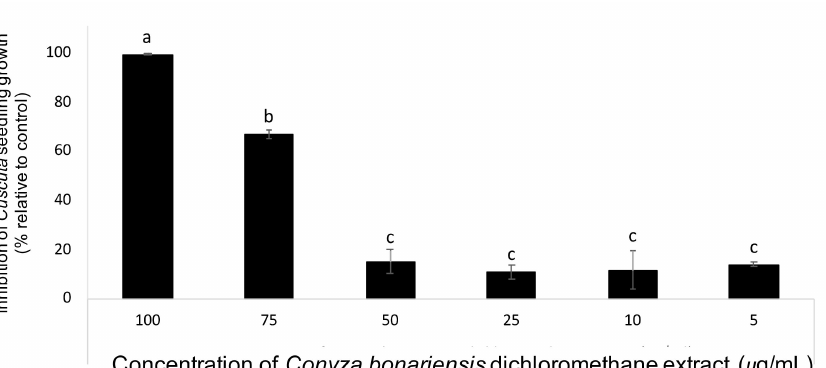
Figure 2. Dose–response screening of the phytotoxic activity on Cuscuta campestris seedling growth of Conyza bonariensis dichloromethane extract. Treatments with different letters are significantly different using the Tukey test ( p = 0.05). Error bars represent the standard error of the